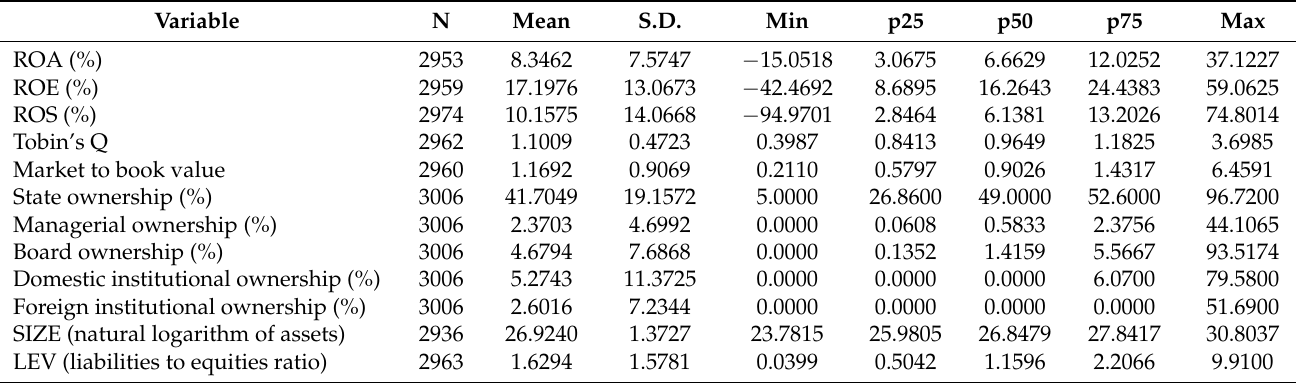
Table 1. Descriptive statistics of